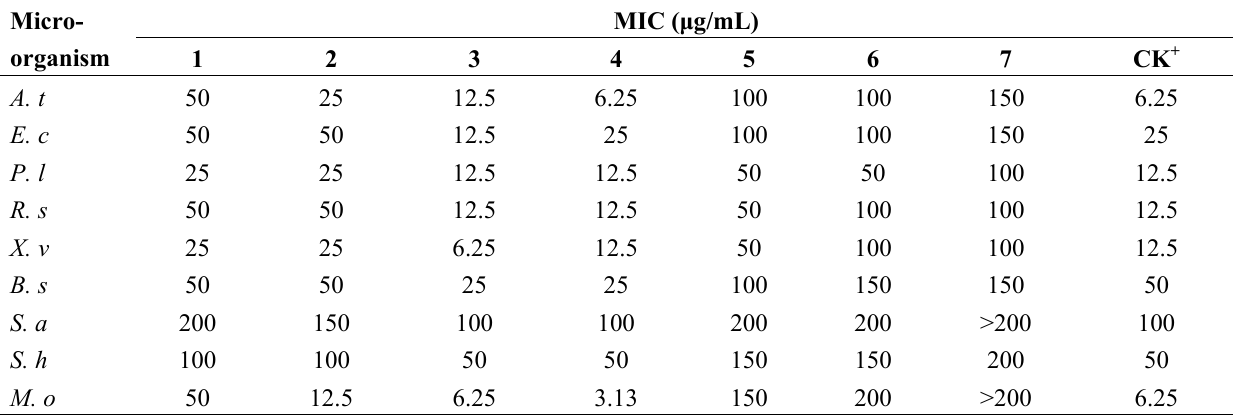
Table 1. MIC values of the compounds 1 – 7 obtained from the cultured hairy roots of S. miltiorrhiza on test microorganisms.